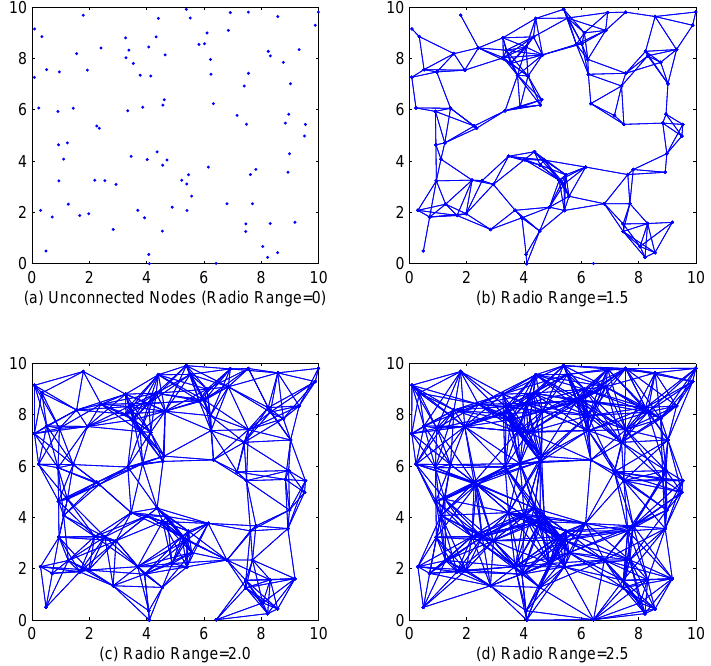
The connected network of 100 randomly distributed sensors with different radio